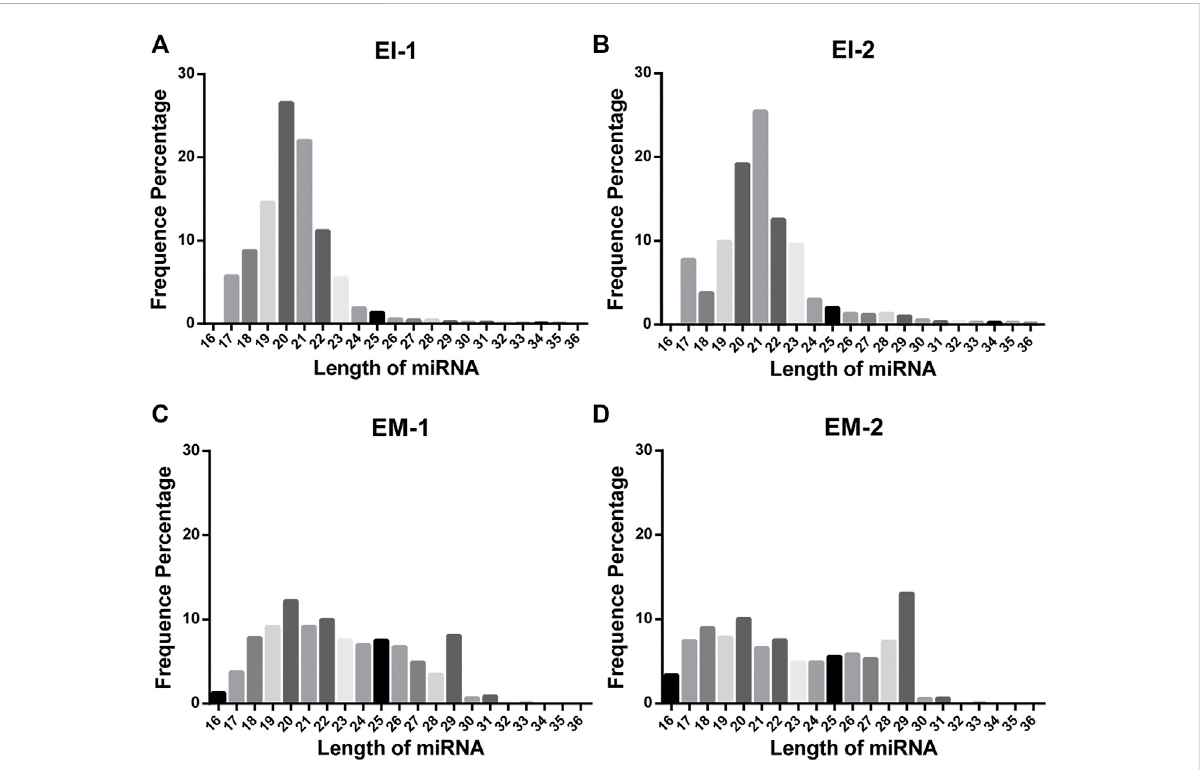
FIGURE 4 LengthdistributionofEVs ’ miRNAsfromtheEIandEMgroups.8 mlofthecellculturemediumsupernatantwascollectedfromHepG2(1.01×10 7 cells per dish), and 13.3 ml supernatant was individually applied for EVs ’ miRNA isolation by each kit. Duplicate samples were analyzed for each group. High-throughput sequencing was performed for EVs ’ miRNAs from the EI and EM group. (A – D) Nucleic acid length distributions of EVs ’ miRNAs isolated by the EI and EM